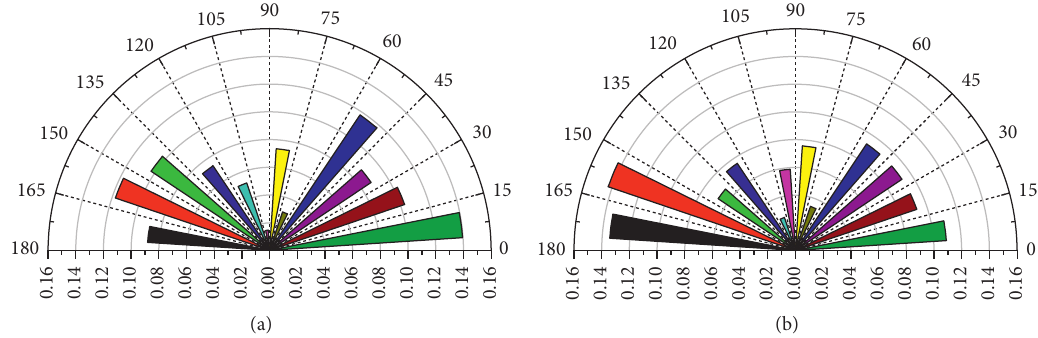
Figure 7: Rose plot for particle orientation distribution. (a) Preexperiment; (b)